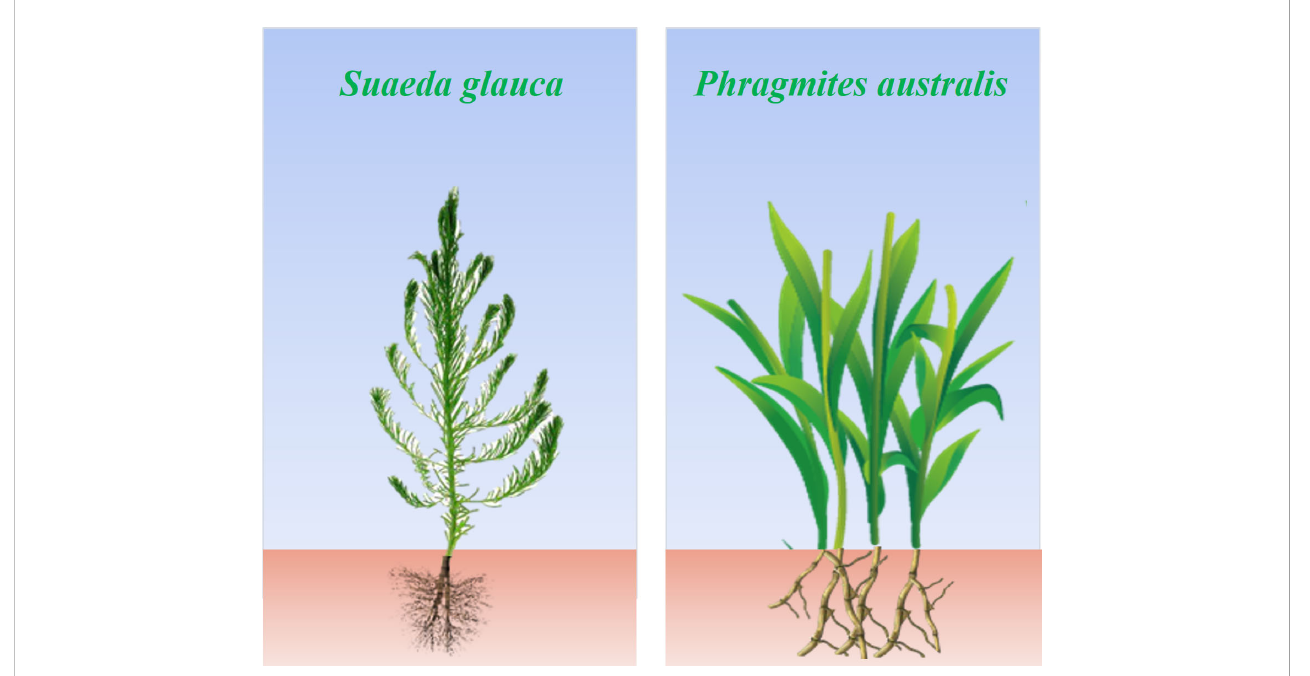
FIGURE 2 S. glauca is a C3 annual forb with fi brous roots; P. australis is a C4 perennial rhizome grass.